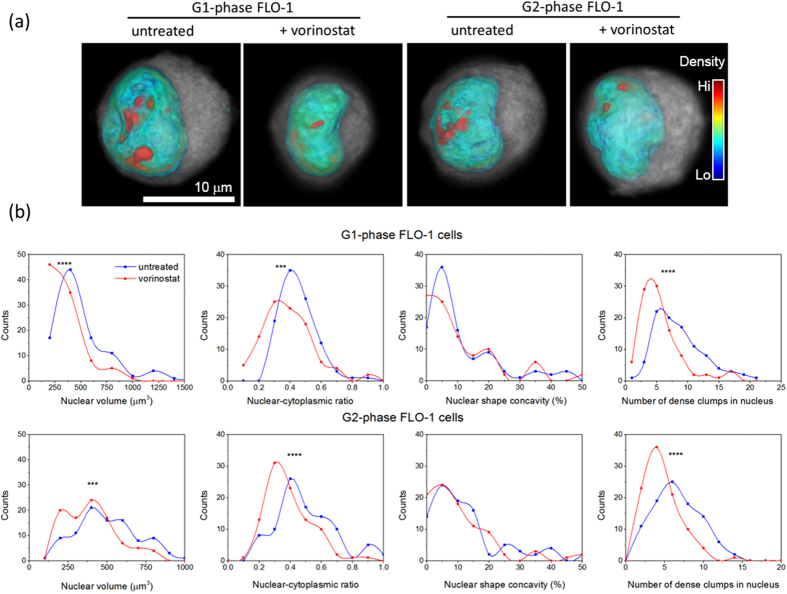
Vorinostat-induced 3D nuclear structure alterations in FLO-1 esophageal adenocarcinoma cells occur in both G1- and G2-phases of the cell cycle.(a) Representative pseudocolor volume renderings of cells imaged by single-cell optical CT illustrate a smoother surface morphology and nuclear interior in vorinostat-treated FLO-1 cells relative to untreated FLO-1 cells from the G1- and G2-phases of the cell cycle respectively. The cytoplasm is gray, nuclear membrane is blue, and increasing nuclear density is color coded from green to red as indicated by the color scale bar. (b) Histograms quantifying the morphological heterogeneity in nuclear size, nuclear cytoplasmic (NC) ratio, nuclear shape concavity, and number of intra-nuclear clumps in vorinostat-treated (red curves) relative to untreated cells (blue curves). Histograms were generated from 100 cells per condition. P-values are indicated by *: ***p < 0.001, ****p < 0.0001. Data were analyzed in Prism6 using the Mann-Whitney test.